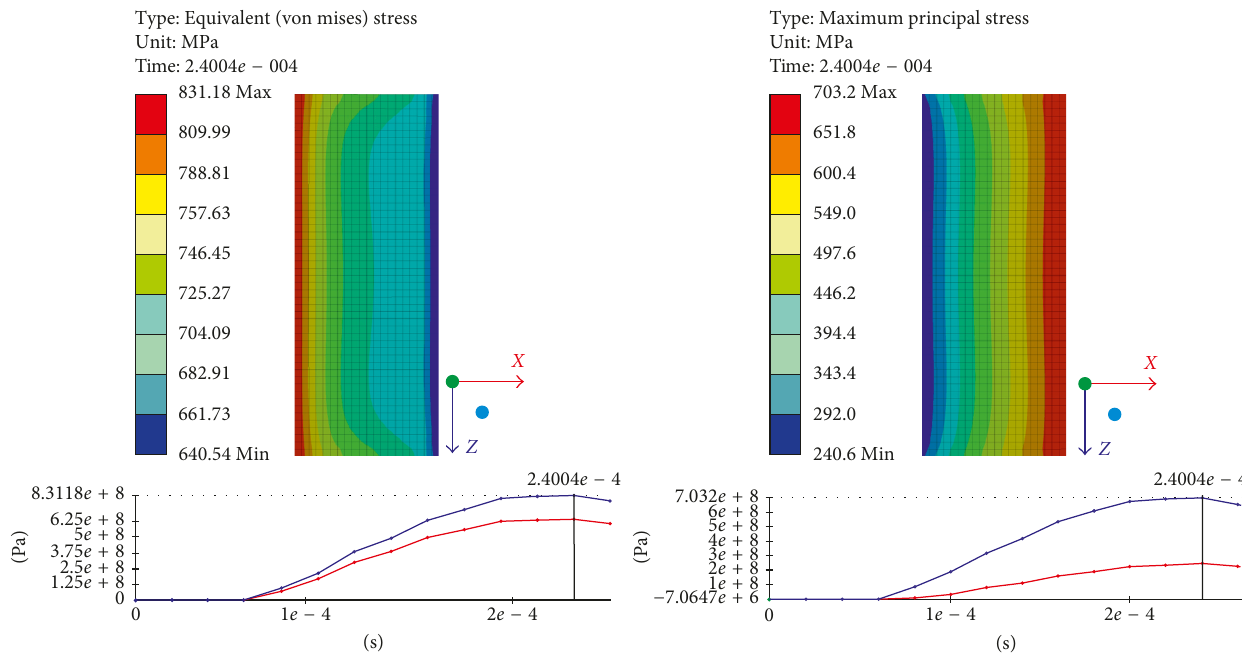
Figure 16: Distribution of reduced stresses (von Mises) in the joint of a block sample dynamically impact loaded (maximum stresses occur on the edge which is opposite to the impact-loaded one).